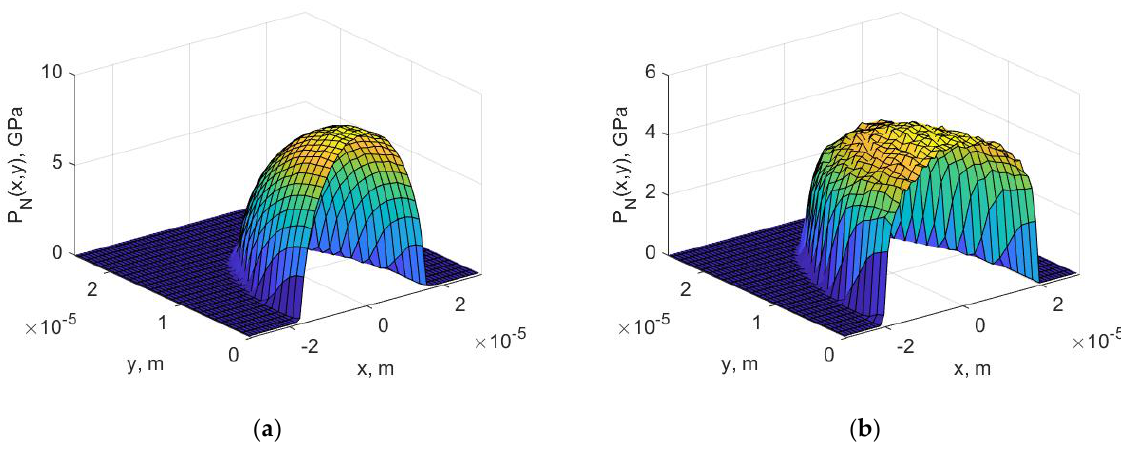
Figure 4. Distribution of normal contact pressure on the surface of the top layer initiated by a spherical indenter with a radius of 200 µm ( a ) elastic contact, ( b ) elasto-plastic contact.